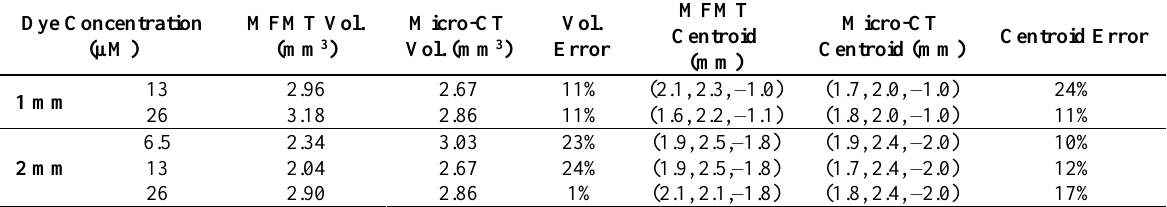
Table 2. Comparison between reconstructed volume and centroid from LOT and micro-CT measurement for the two depths